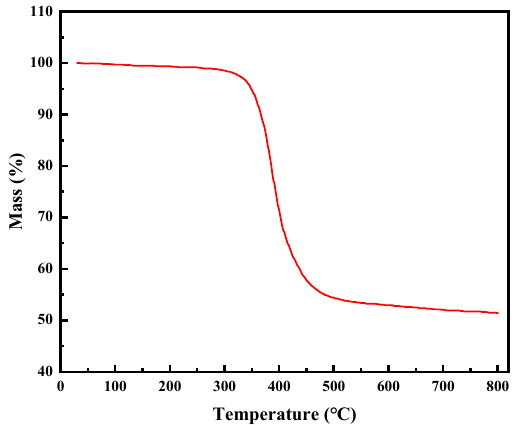
Figure 1. TGA result of the GFRP powder. Table 3. Codes of asphalt